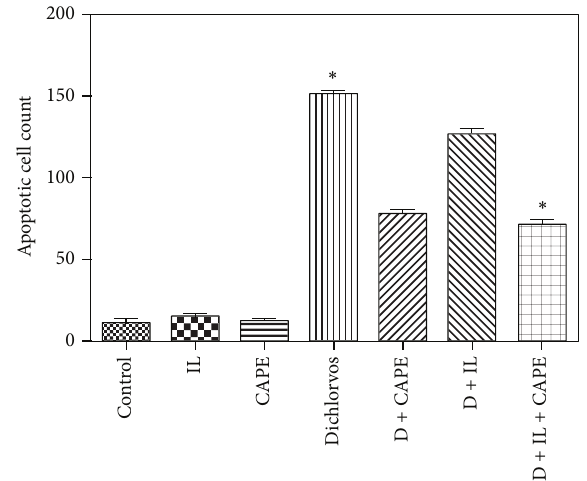
Figure 3: Histopathologic results for kidney tissues. Apoptotic cell count. ANOVA test (intralipid (IL), Dichlorvos